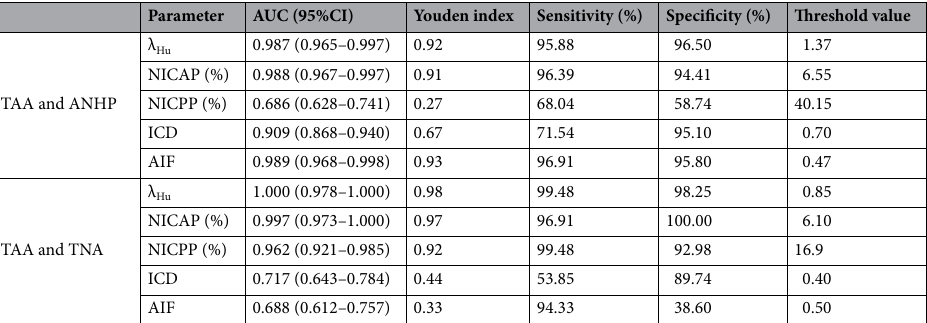
Table 5. Diagnostic performance of each parameter in distinction of different tissues. λ Hu , Slope of the spectral Hounsfield unit curve; NICAP, normalized iodine concentration at arterial phase; NICPP, normalized iodine concentration at portal venous phase; ICD, iodine concentration difference; AIF, arterial iodine fraction; TAA, tumor active area; ANHP, adjacent normal hepatic parenchyma; TNA, tumor necrotic